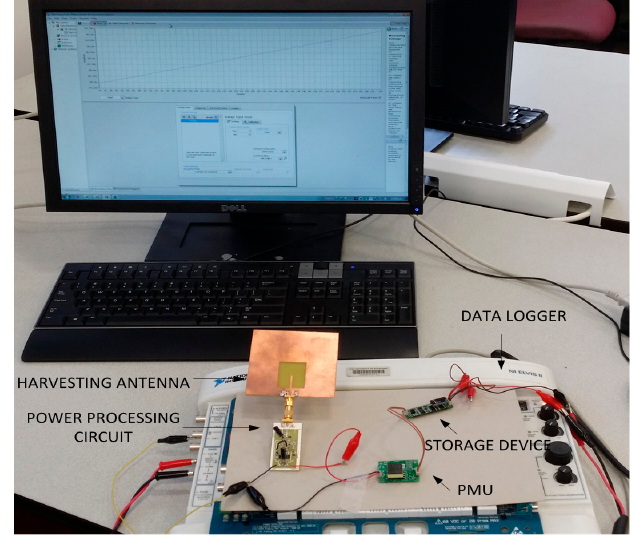
Figure 17. The actual figure of the proposed RF energy harvesting system.